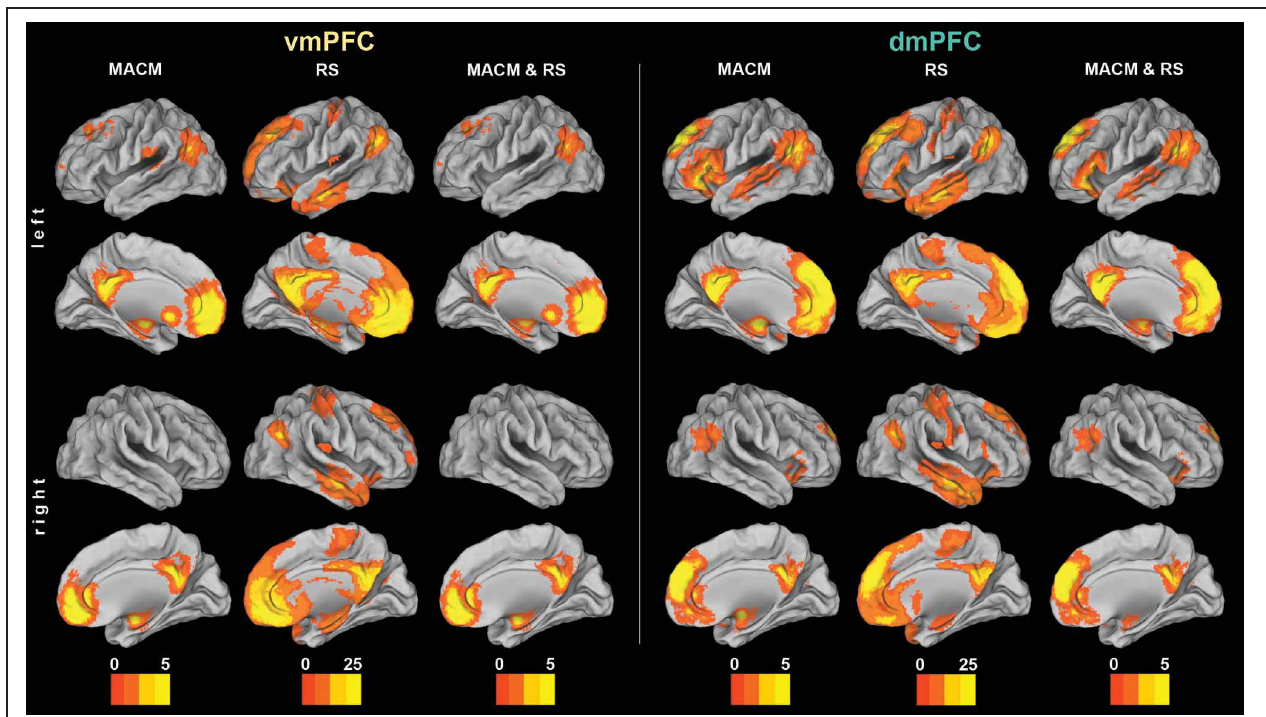
to Tables 1 , 2 for peak coordinates. All images were rendered using Caret (computer assisted reconstruction and editing toolkit; http://brainvis.wustl.edu/wiki/index.php/Caret: About). Cortical sheet inflation enhances visual intuitiveness and alleviates activation burying in